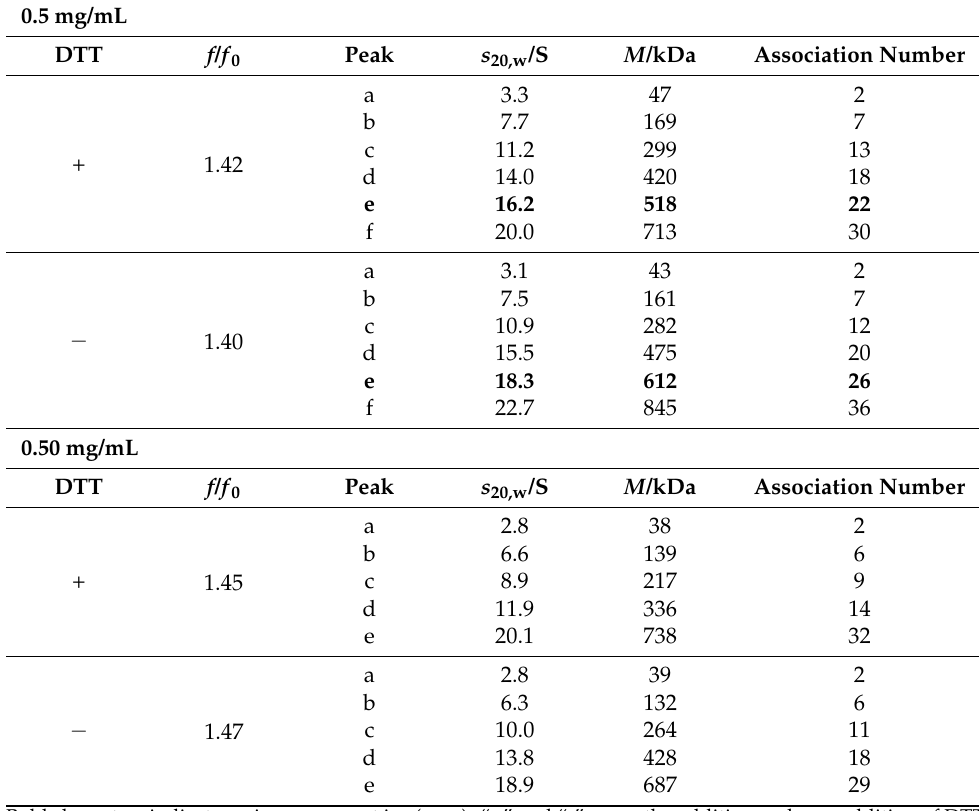
Bold characters indicate main component in c ( s 20,w ). “+” and “-” mean the addition and non-addition of DTT, respectively.